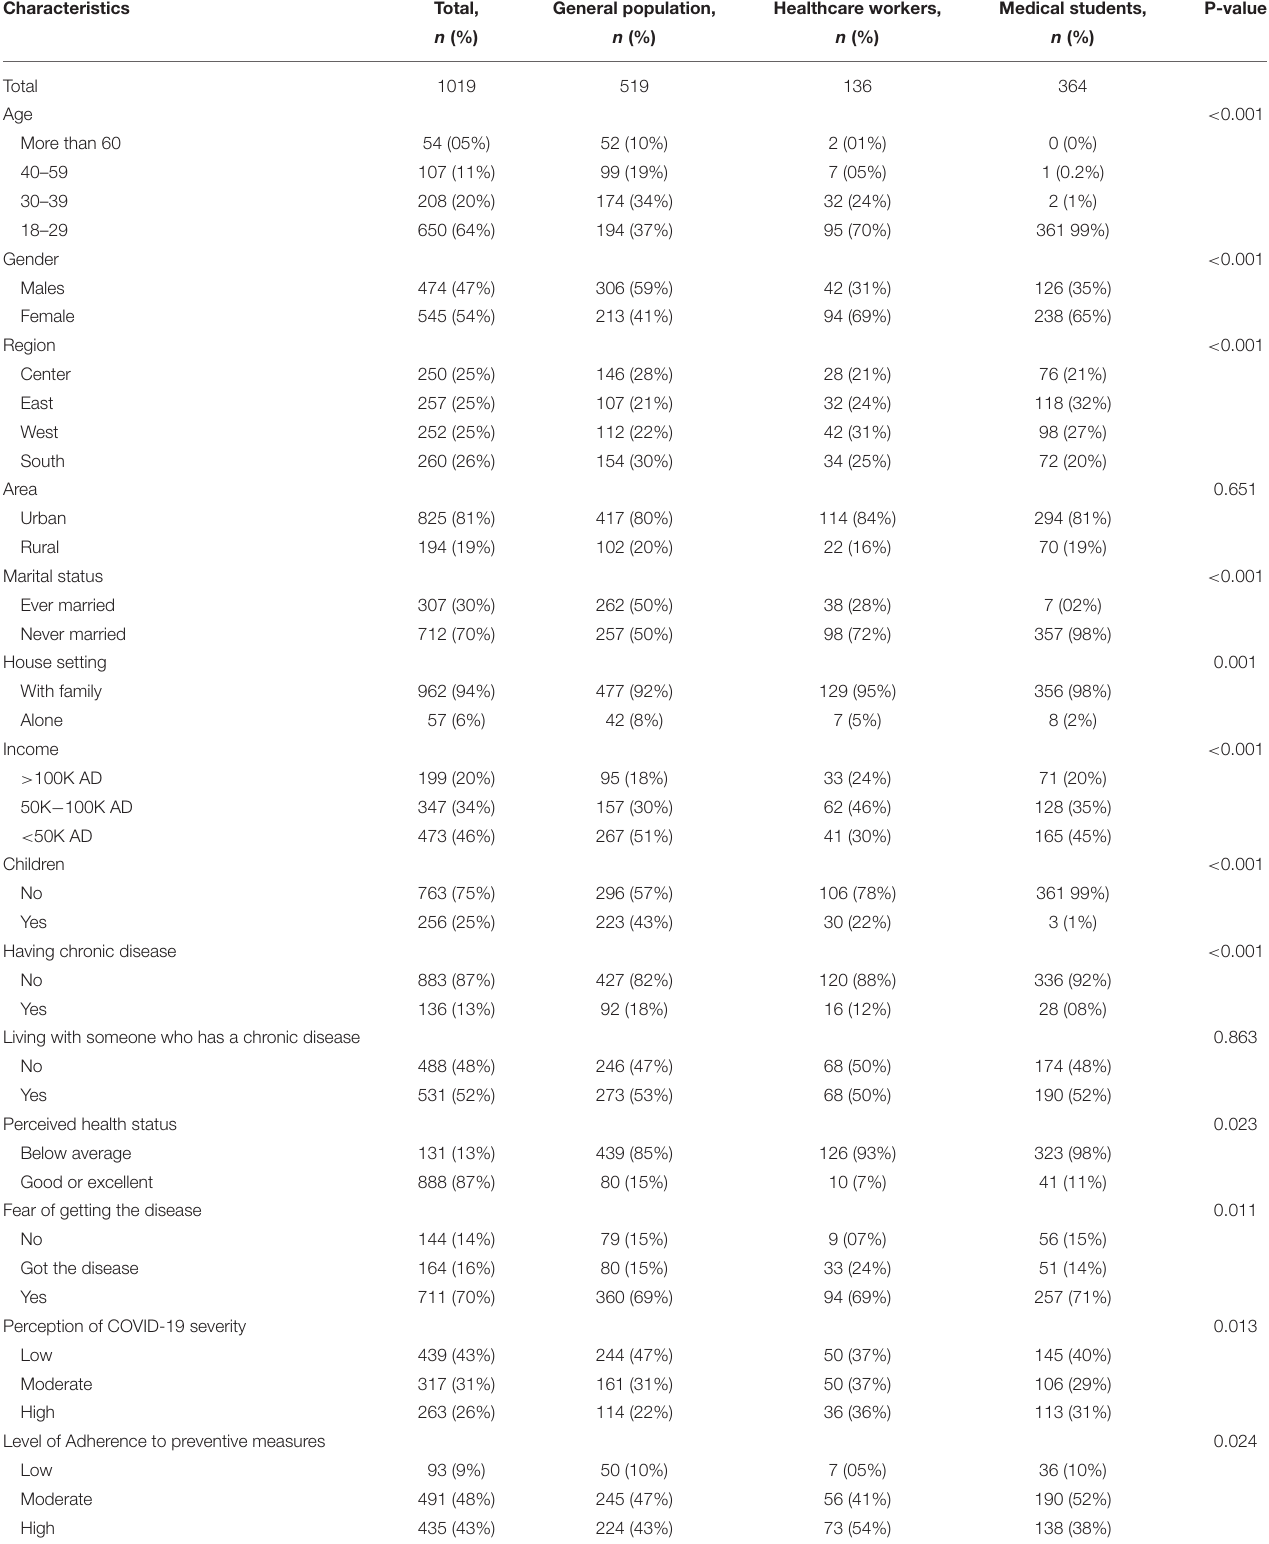
TABLE 1 | Sociodemographic characteristics and answering patterns to different questionnaire scales in total population and by comparison between healthcare workers vs. medical students vs. the general population.